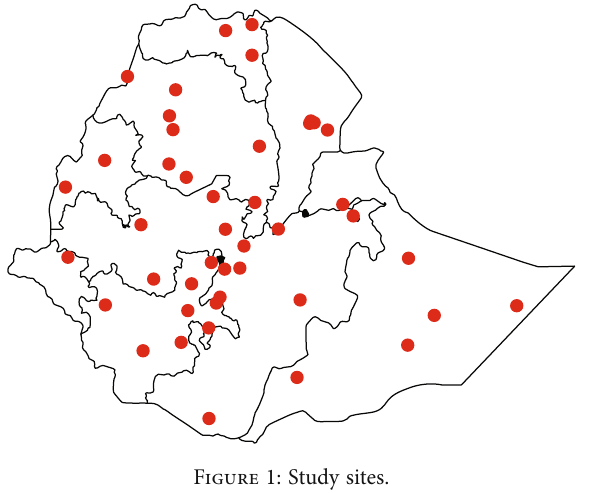
Figure 1: Study sites.